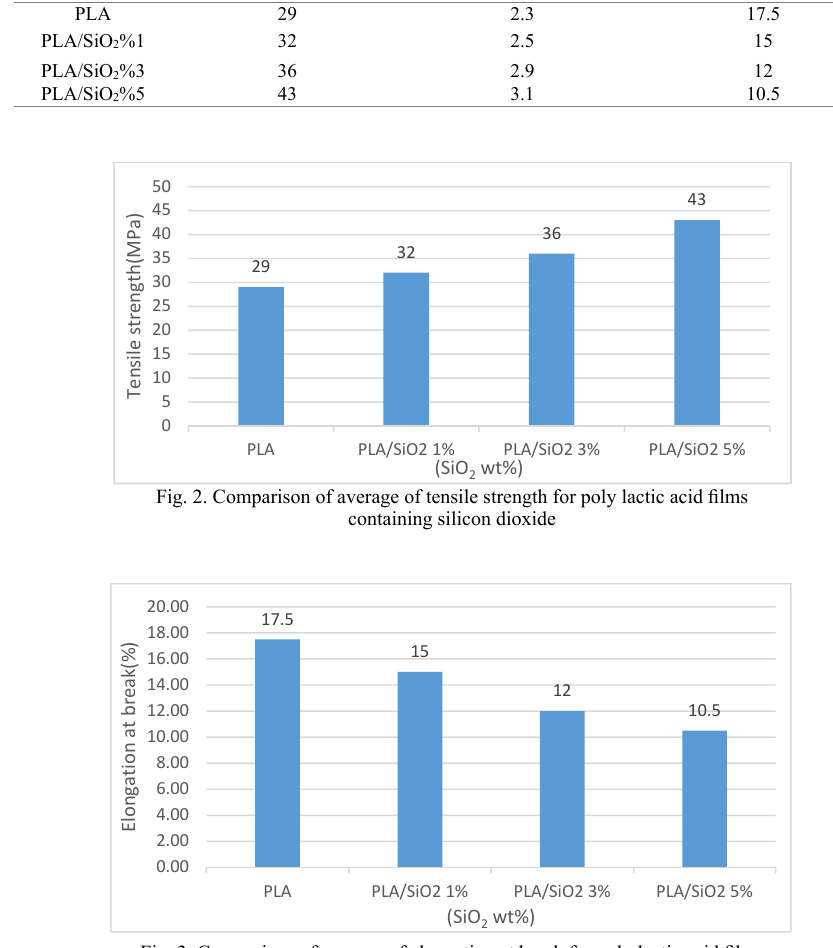
Fig. 3. Comparison of average of elongation at break for poly lactic acid films Fig 3 . Comparison of average of elongation at break for poly lactic acid films containing silicon containing silicon dioxide dioxide nanoparticle